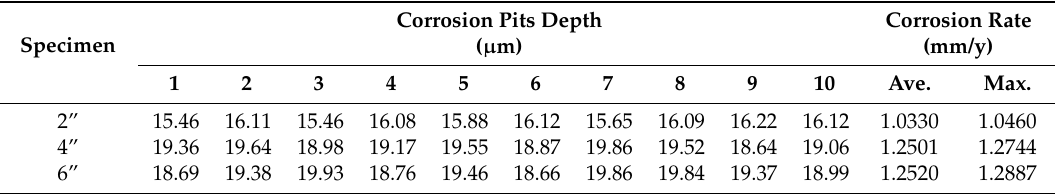
Figure 11. Surface morphology and profile of 2” steel pipe specimen: ( a ) surface morphology and ( b ) profile along the line. Table 6. Localized corrosion rate for the three steel pipelines.